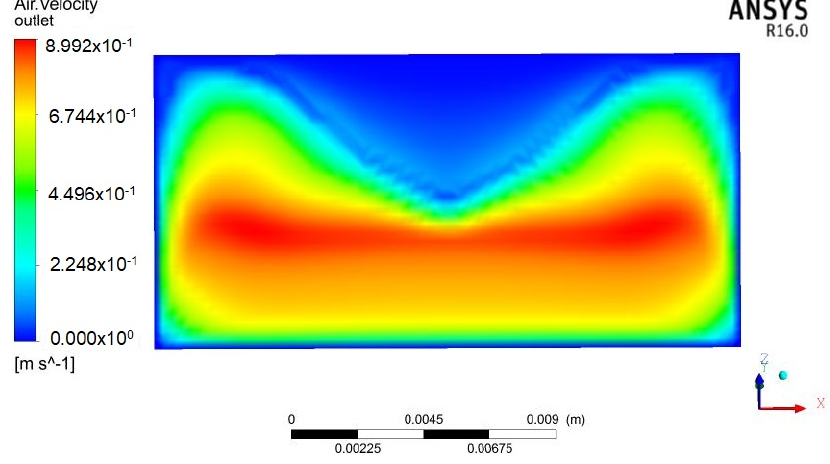
Figure 7. Air velocity at the outlet.